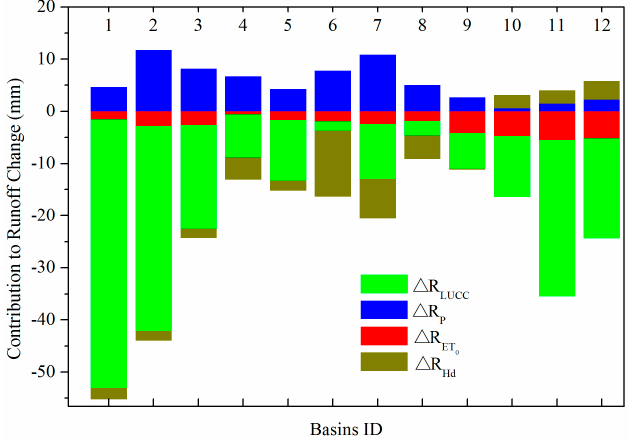
Figure 4. Contribution of the four factors to runoff change in the 12 catchments between the periods 1980–1999 and 2000–2013.